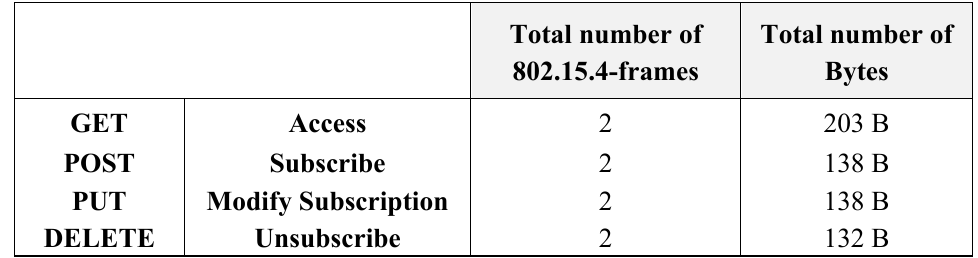
Table 2. Analysis of the Proposed